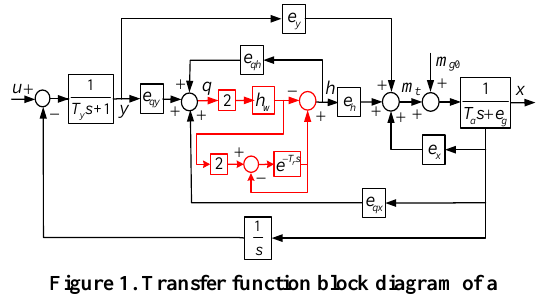
Figure 1. Transfer function block diagram of a hydro-turbine governor